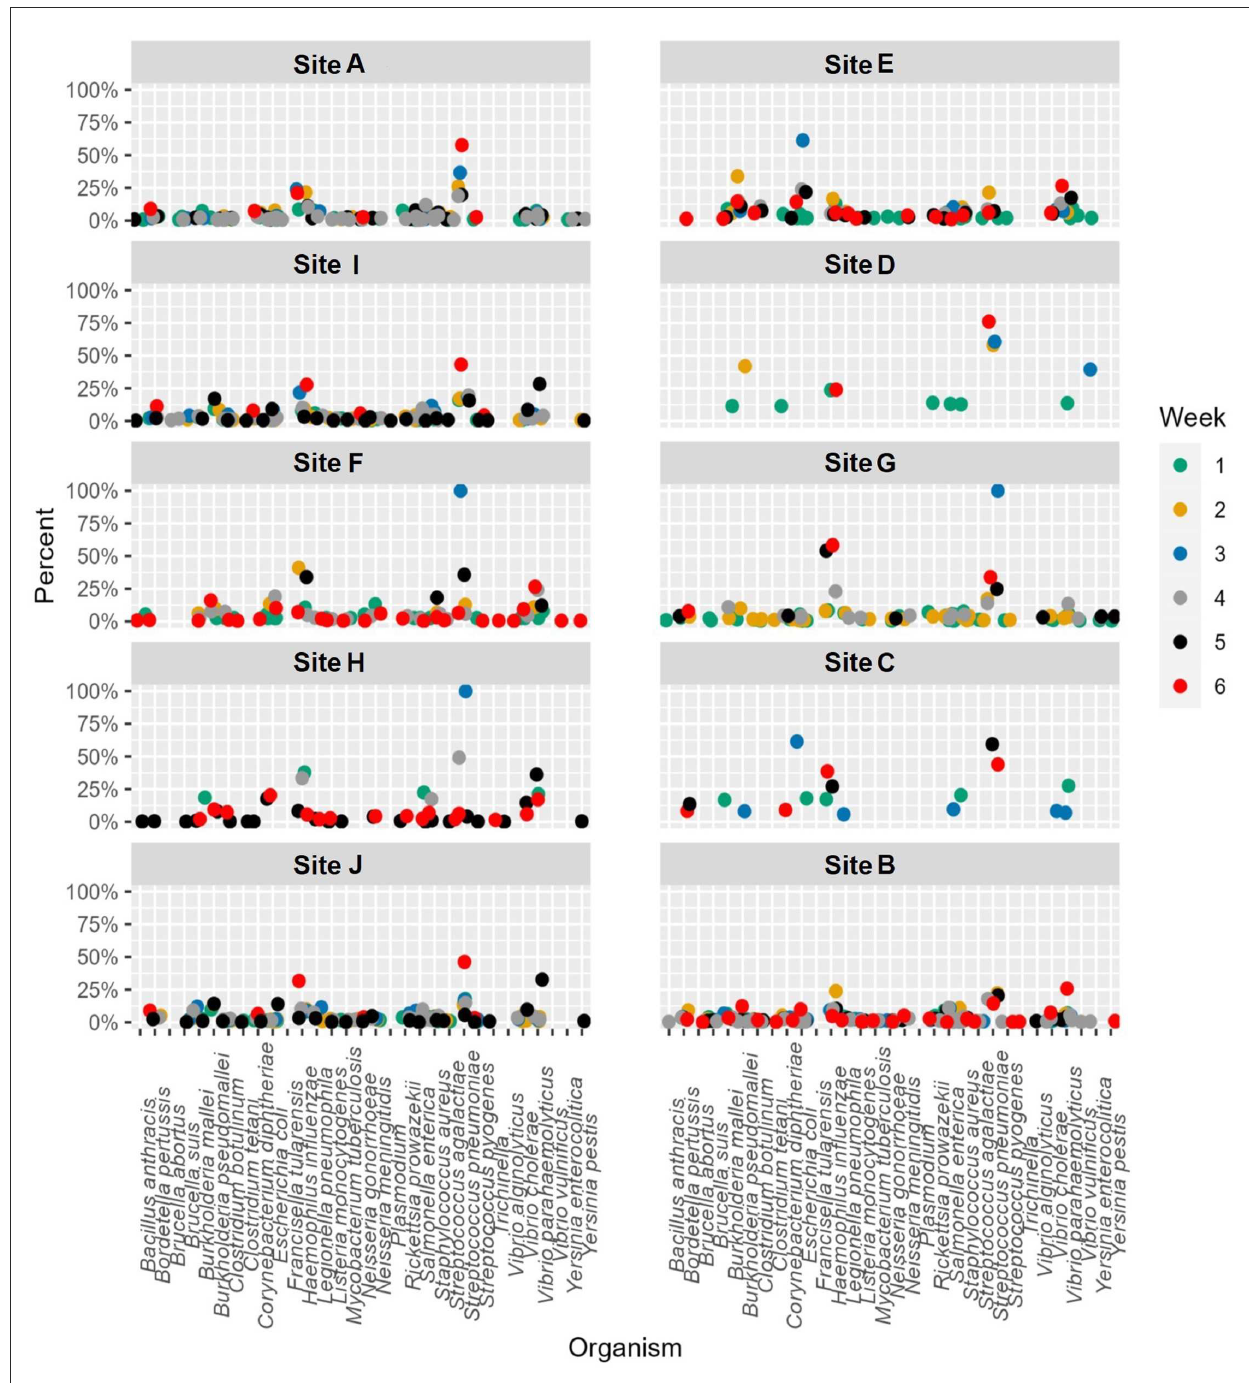
FIGURE5 Abundance by site per week for etiological agents of Ohio Department of Health reportable diseases using the Contig-based approach to data analysis.